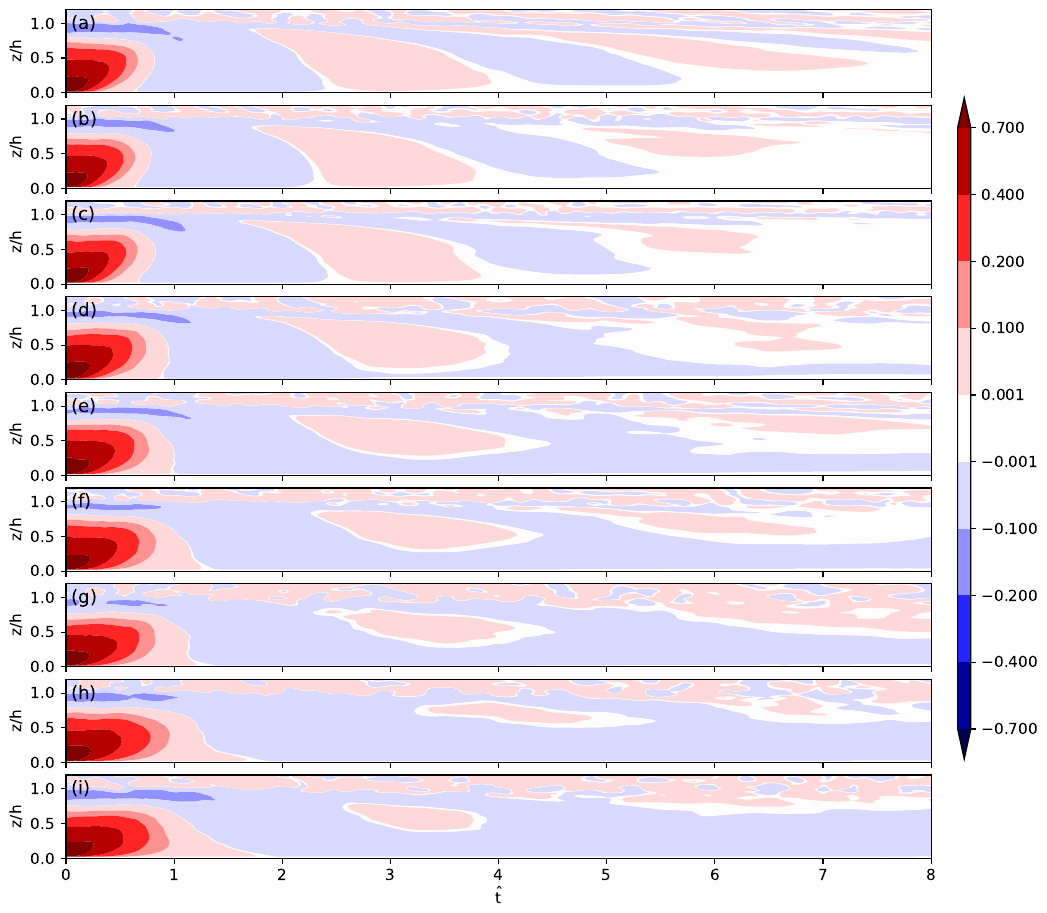
Figure 7. Time series of vertical profiles of normalized vertical heat flux in the ( a ) B3, ( b ) B2, ( c ) B1, ( d ) I3, ( e ) I2, ( f ) I1, ( g ) S3, ( h ) S2, and ( i ) S1